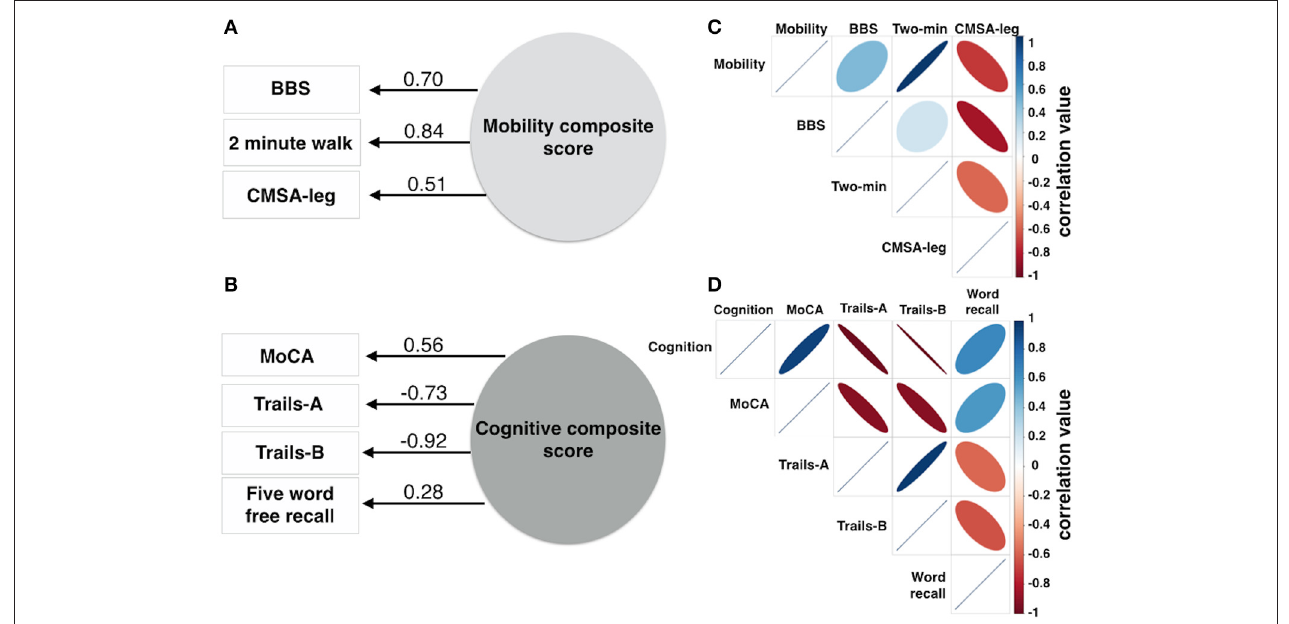
FIGURE 2 | Composite scores for mobility and cognition were derived from 3 or 4 variables, respectively. Factor analysis produced one factor for mobility (A) and one factor for cognition (B) . The numbers adjacent to the lines in (A,B) denote the factor loadings onto the composite score. The correlation matrix describes the individual correlation for the mobility data (C) and cognitive data (D) . The color bars in (C,D) represent correlation coefficient values ranging from − 1 to 1. The size of the ellipse indicates the degree of shared variance between each of the variables (wide ellipse, low correlation; narrow ellipse, high correlation). BBS, Berg Balance Scale; CMSA-leg, Chedoke-McMaster Stroke Assessment leg score.